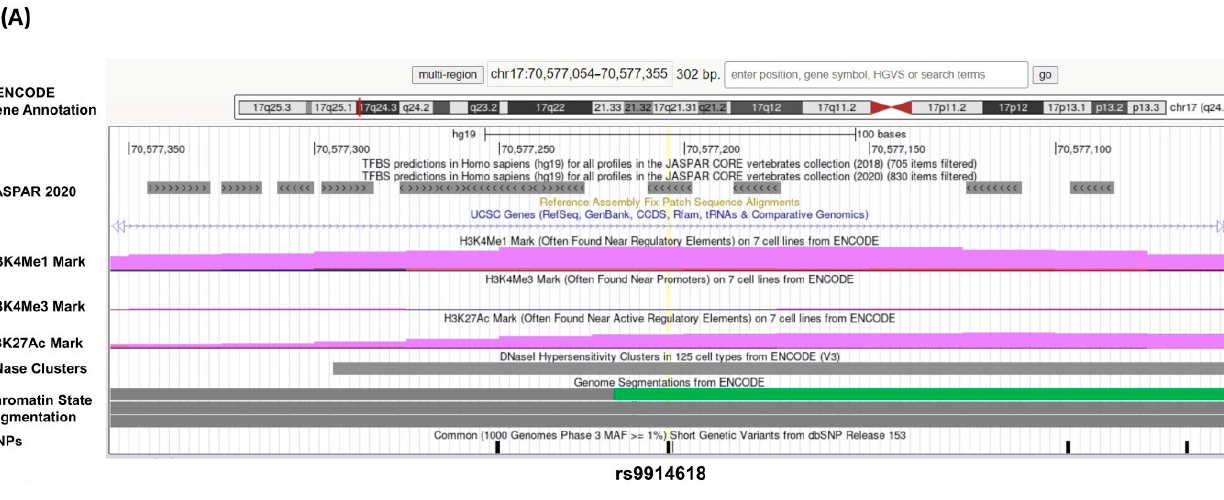
. Figure 2. Intron structure of LINC00673 (NR_137201.2) and the features of rs9914618. ( A ) The intron spanning the chromosome position chr17:70,577,054 to 70,577,355 (reference genome GRCh37.p13) is shown, and the SNPs of LNC00673 are indicated by the black bars. rs9914628 is centered and marked with reference SNP ID number. The H3K4Me1, H3K4Me3, and H3K27Ac tracks exhibit the enrichment of the mono-methylation of lysine 4, trimethylation of lysine 4, and acetylation of lysine 27 of the H3 histone protein, as determined in ENCODE project. DNase clusters track indicates DNase hypersensitivity regions. Chromatin State Segmentation tracks display chromatin state segmentations by integrating ChIPseq data with a hidden Markov model for H1-hESC embryonic stem cells. The chromatin state region predicted for transcribed regions is highlighted in green. ( B ) Sequence of the intron 1 region. The putative NFYB binding motif (MA0502.2) is shown in bold fonts. Y indicates the position of rs9914628 and denotes C or T. ( C ) Motif logo of NYFB consensus sequences. 4. Discussion Accumulative evidence has manifested that OSCC progression is a multi-step process orchestrated by both genetic and environmental factors. Here, we reported that LINC00673 SNP, rs9914618, mediated the invasive potential of OSCC but did not confer the susceptibility to oral malignancies. When comparing only patients who were habitual